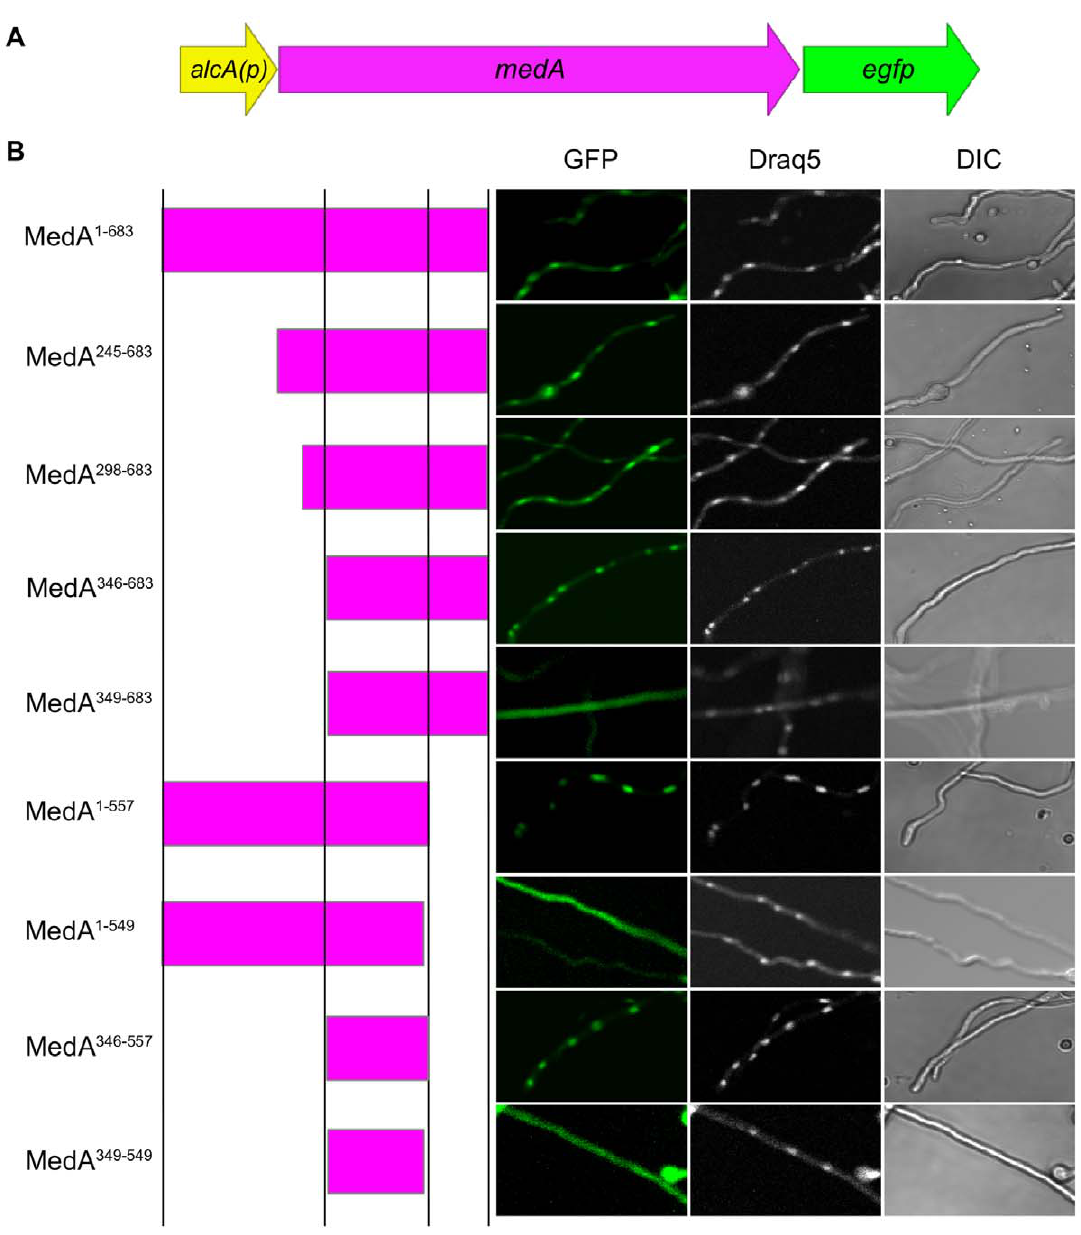
Figure 1. Subcellular localization of the MedA-EGFP fusion truncation constructs in A.fumigatus . (A) Schematic overview of the various truncated medA-egfp gene fusions. Full-length medA and different medA truncations were fused in-frame to egfp under the control of alcA promoter. (B) The cellular localization of various MedA-EGFP fusion proteins expressed in A. fumigatus Af293. Nuclei were stained by Draq5 and mycelia were analyzed by light microscopy. Left, center, and right columns show the GFP, Draq5, and DIC (Differential Interference Contrast), respectively. The MedA-GFP constructs are indicated on the left side. Vertical lines, from left to right, represent amino acids 1, 346, 557, and 683 respectively.